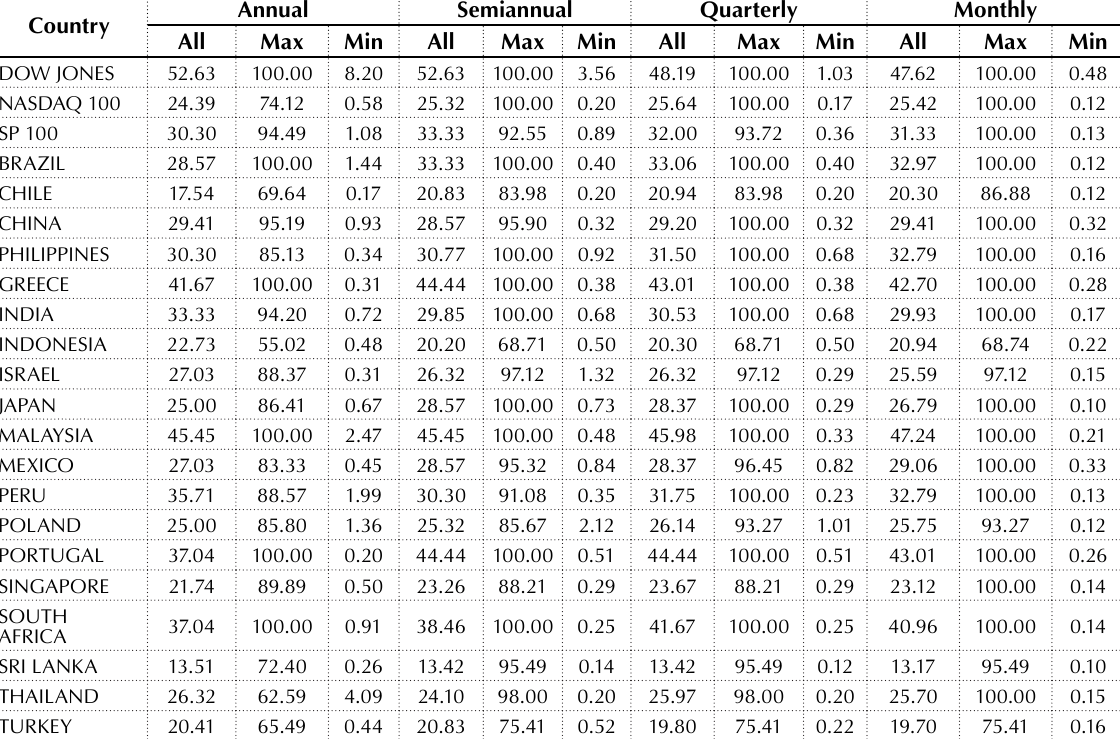
Table 5. Portfolio weights of mean-variance